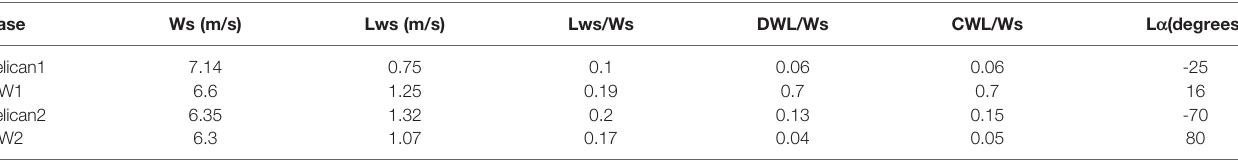
TABLE 3 | Calculation of the drift characteristics for the